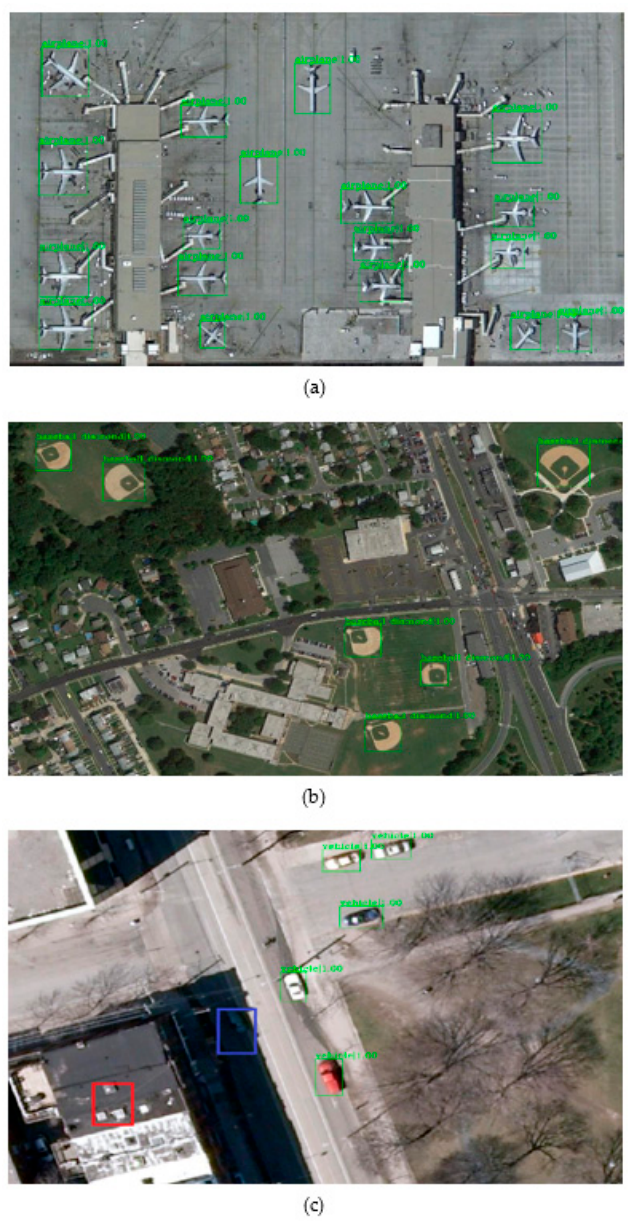
Figure A1. Object detection examples on the NWPU-VHR10 dataset: ( a ) plane; ( b ) baseball diamond; ( c ) vehicle.